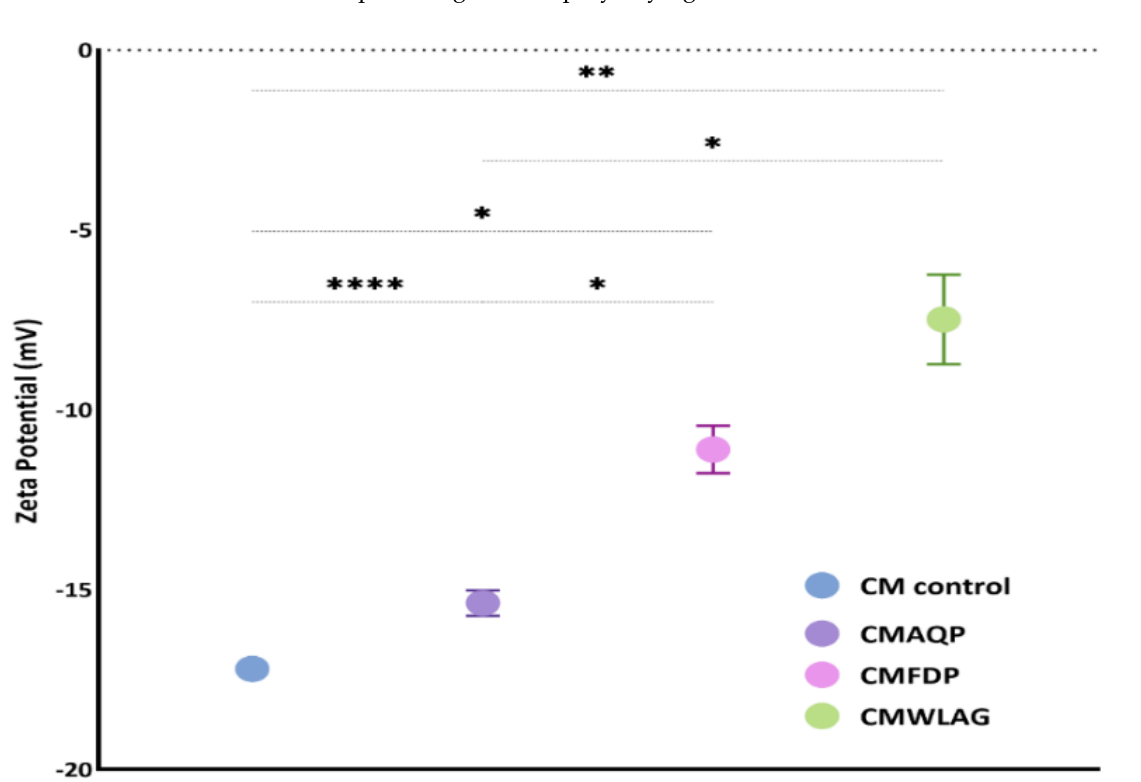
Figure 2. Zeta − potential of spray-dried powders of controlled casein micelles (CMs), CMAQP, CMFDP, and CMWLAG. (Values are from triplicates; the mean and standard deviation are shown. Values significantly different of all spray-dried powders (CMAQP, CMFDP, CMWLAG) from CMs controlled when analyzed by one − way ANOVA with Dunnett’s test analysis indicated with asterisks: * p < 0.01, ** p < 0.001, **** p < 0.0001.). Table 1. Moisture contents, pH, color, and visual observations of spray-dried powders of anthra- quinone-loaded casein micelles. (Values are mean and standard deviations from triplicate data. The data were analyzed using one-way ANOVA and Tukey’s post hoc HSD tests. The different letters in superscript (a, b, c) within rows indicate statistically significant differences ( p < 0.05).